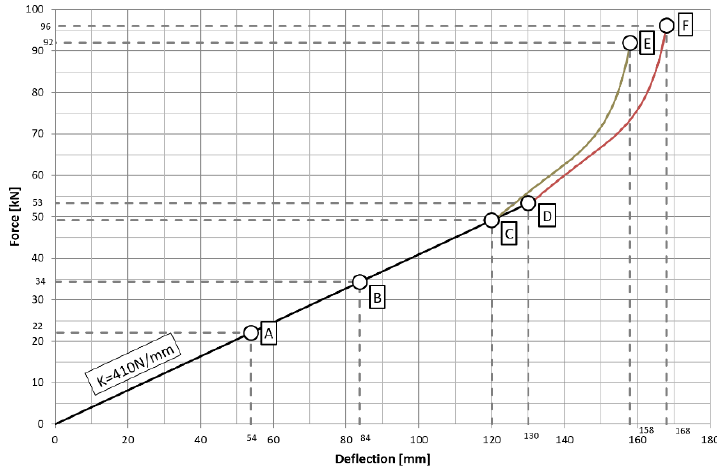
Figure 2. Characteristics of spring stiffness with buffers.